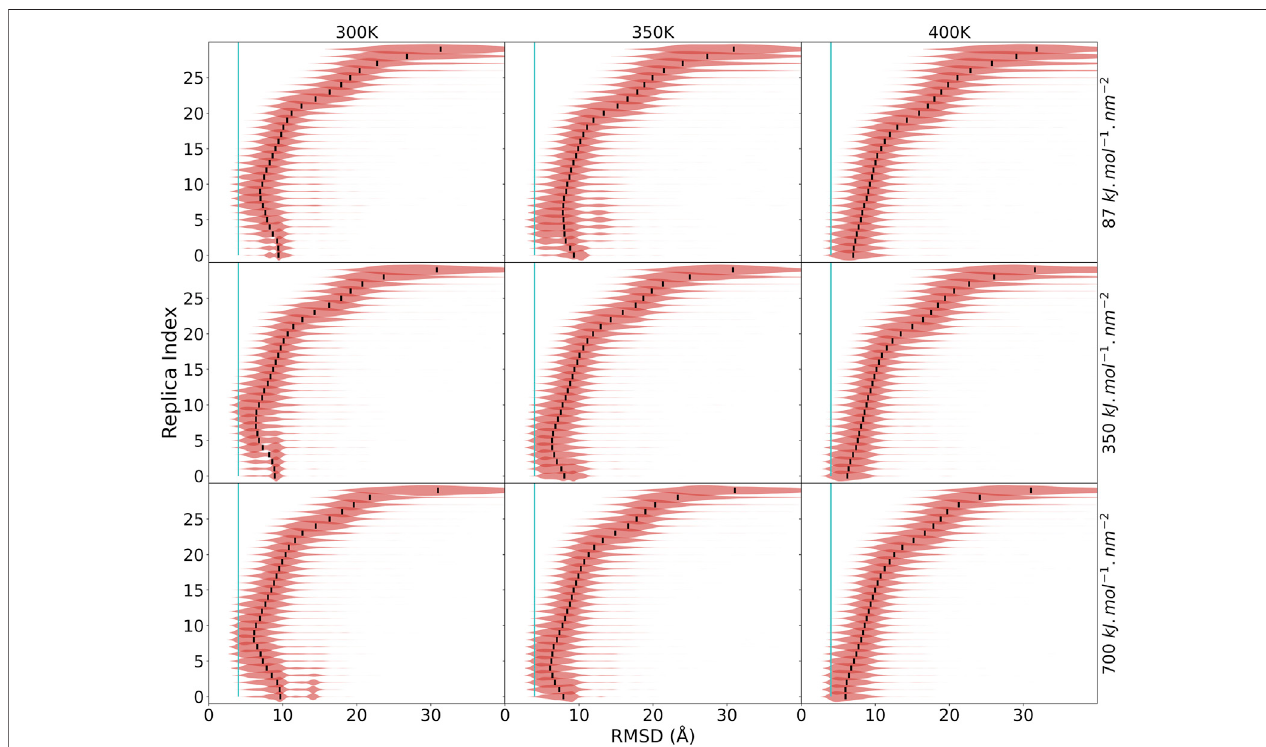
FIGURE3| FunnelingplotsfortargetN0957s1.Eachpanelisadifferentprotocol.EachlineisaviolinplotoftheRMSDdistributionatthatreplica,withthemedianof the distribution marked in black. The vertical cyan line shows RMSD (cid:2) 4 Å.